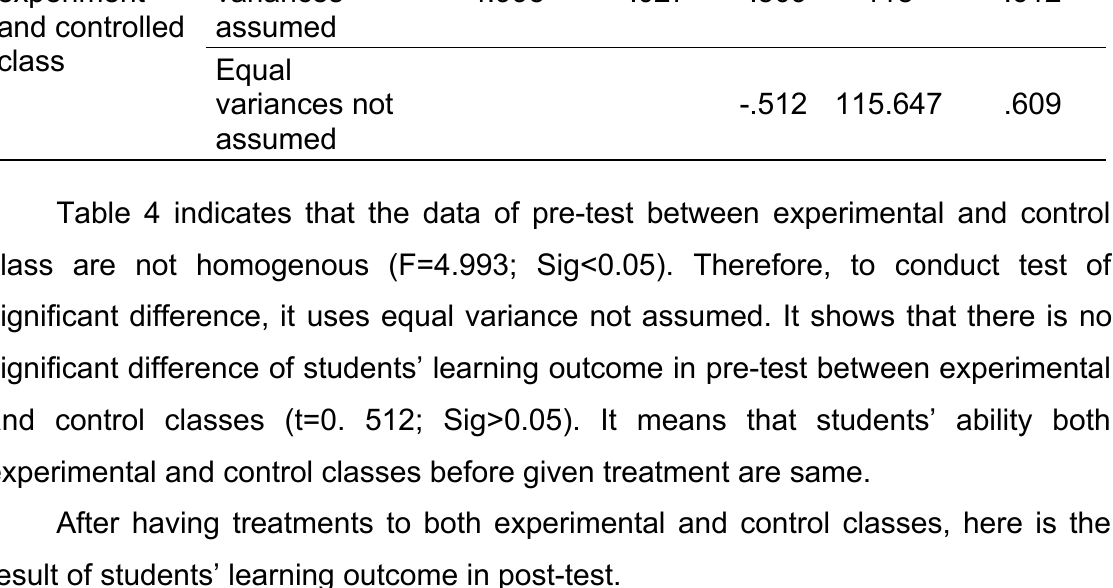
Table 5. Description of mean score of post-test between experimental